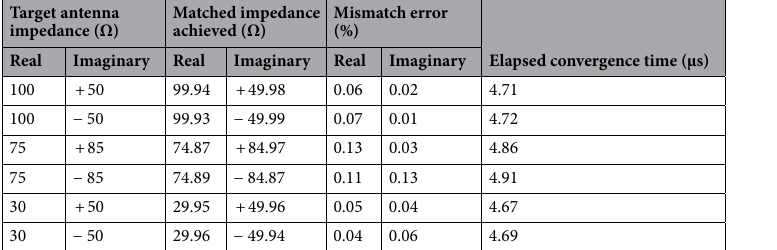
Matched impedance achieved